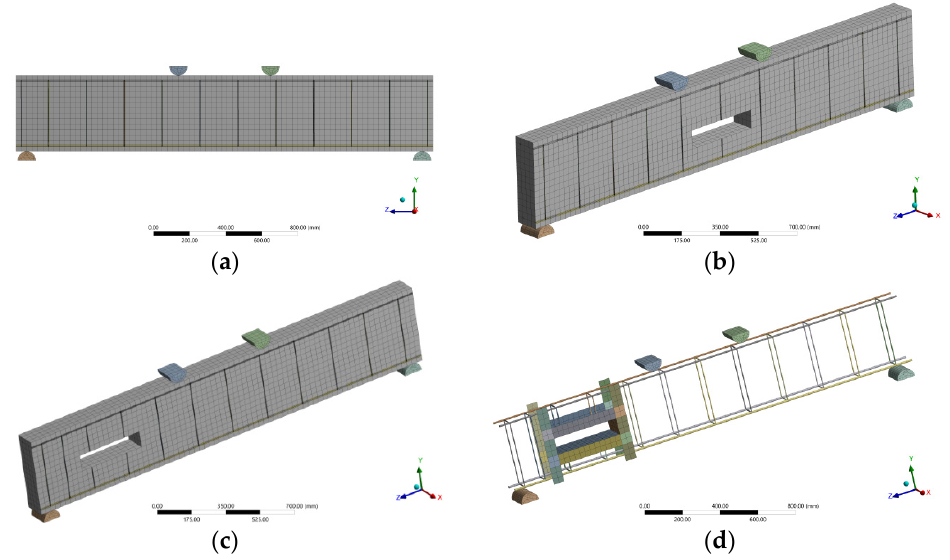
Figure 3. Finite Element Modeling. ( a ) control beam; ( b ) tension-zone opening; ( c ) shear-zone opening; ( d ) beam reinforcement.